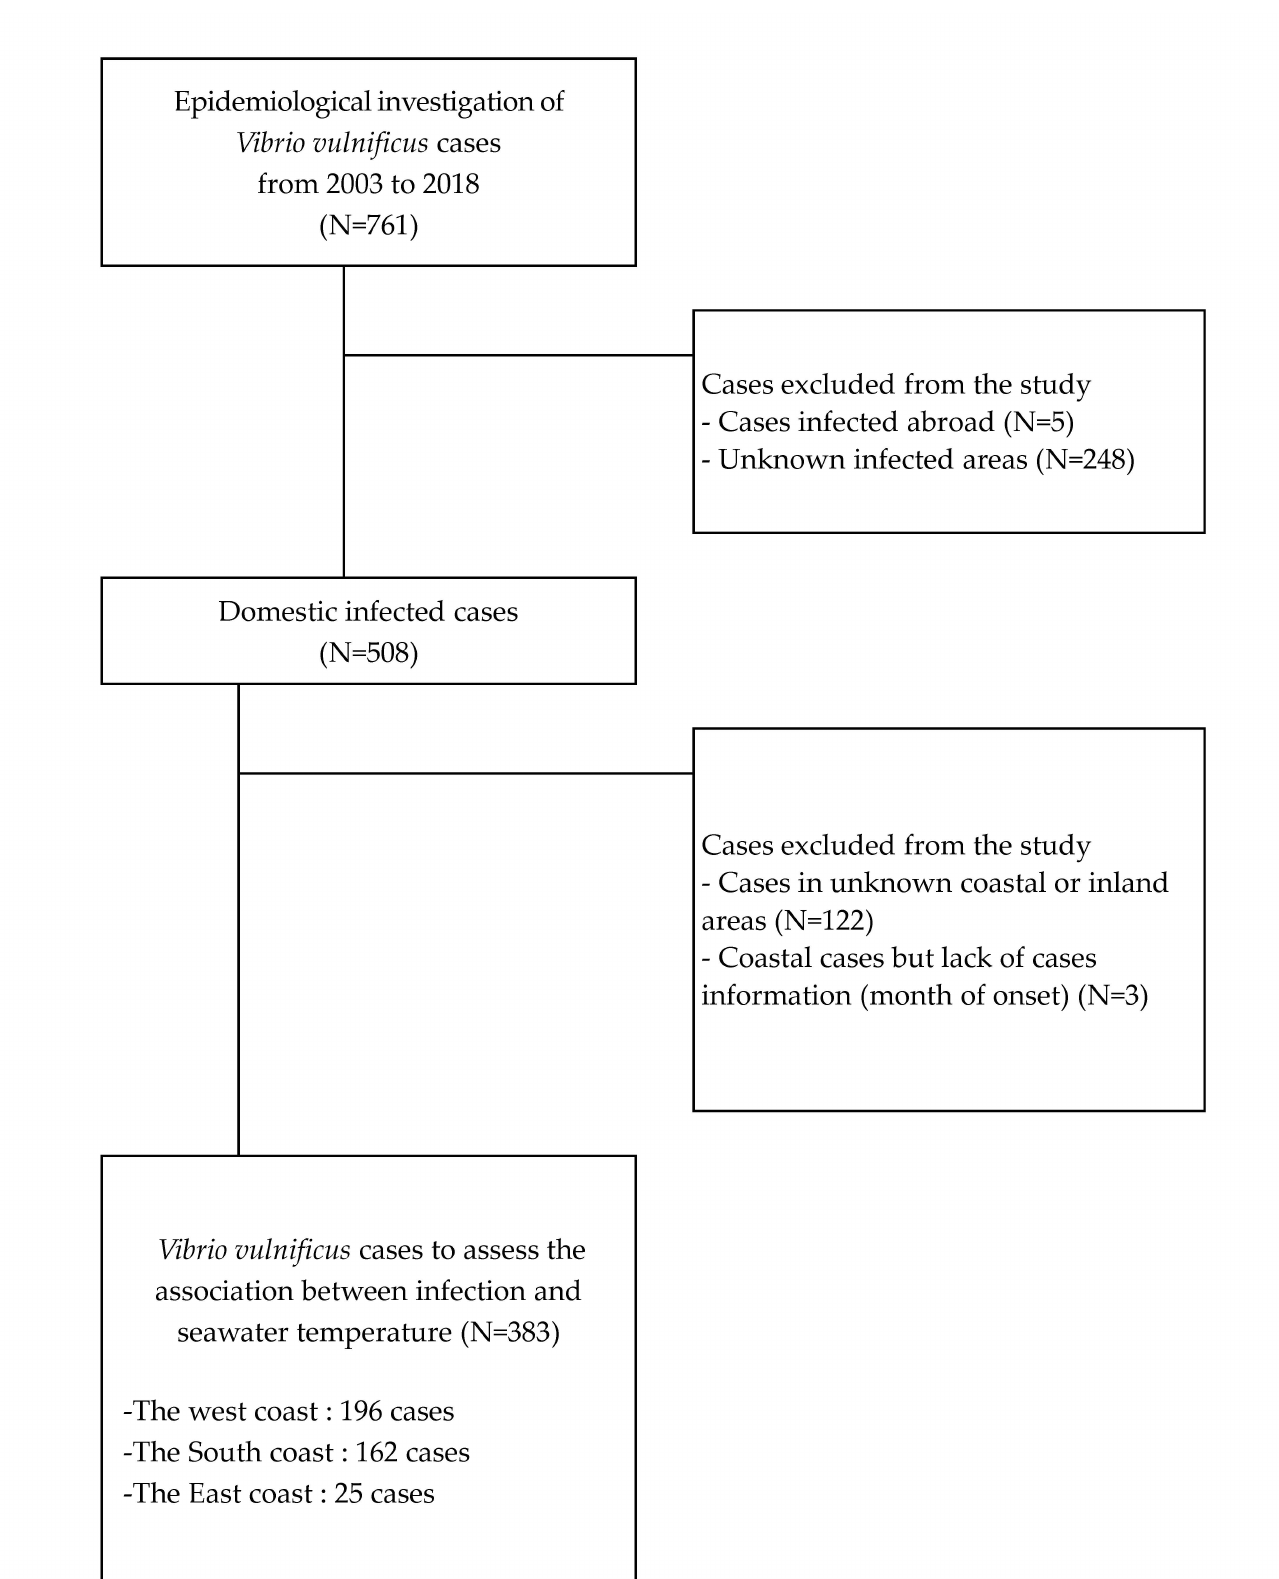
Figure 2. The selection of the study